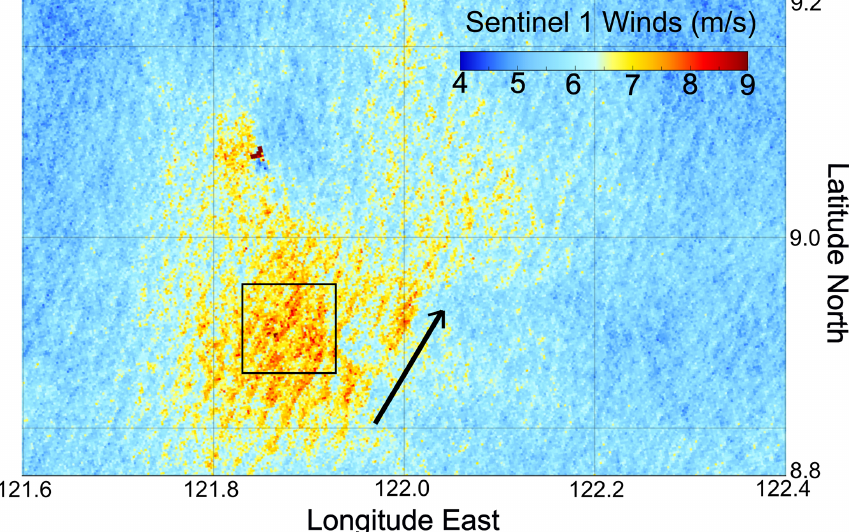
Figure 1. A 250m resolution image taken from the Sentinel-1 synthetic aperture radar (SAR), post-processed to show surface winds at the Sulu Sea on 1 September 2019. For scale reference, the black box represents a square distance of 11km in each cardinal direction. The black arrow represents the orientation of the wind direction as given by the ERA5